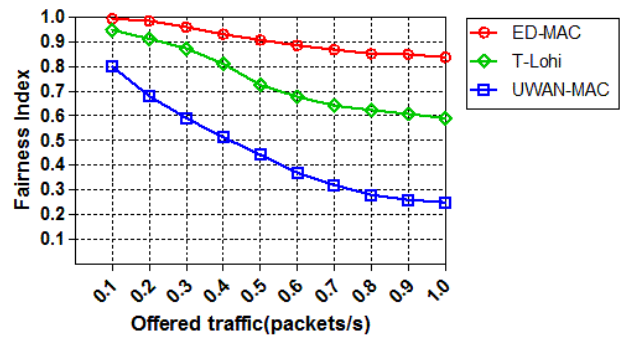
Figure 17. Fairness vs. offered traffic.